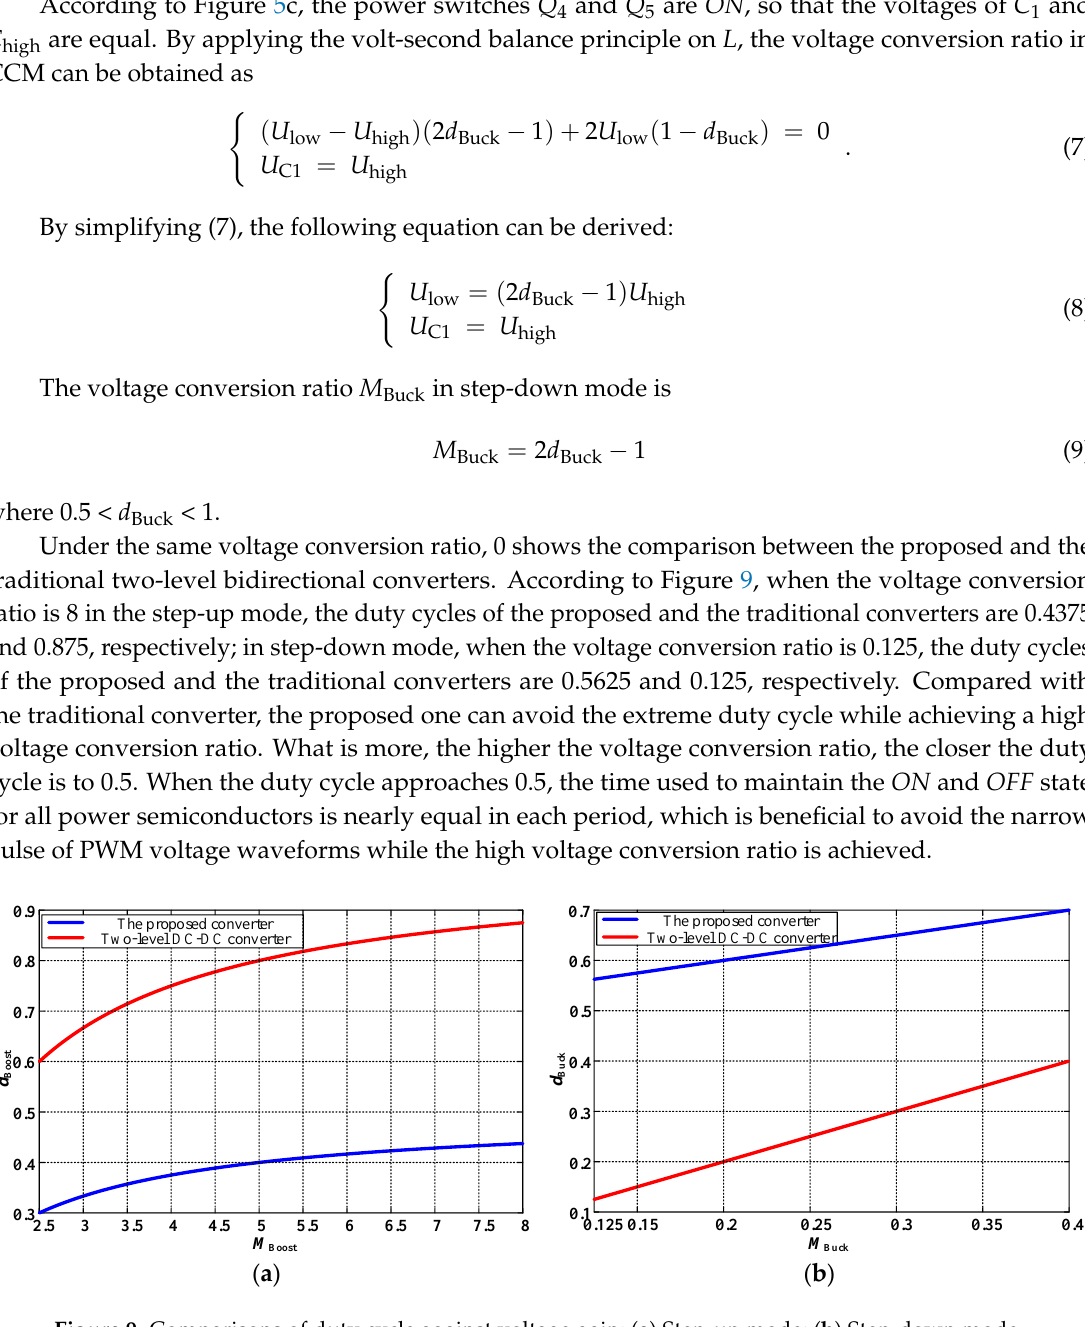
Figure 9. Comparisons of duty cycle against voltage gain; ( a ) Step-up mode; ( b ) Step-down mode.